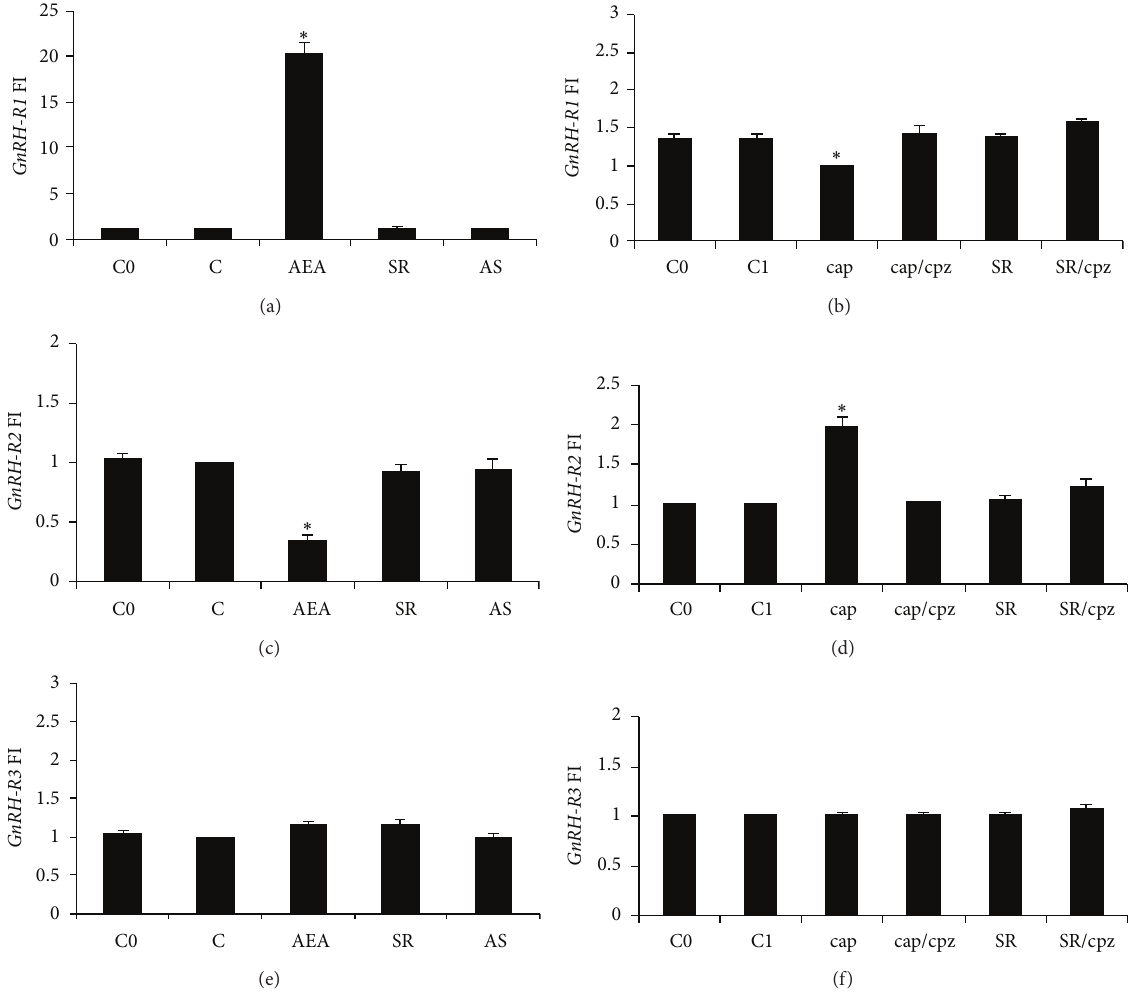
Figure 4: Effects of AEA treatment on GnRH-R1 (a), GnRH-R2 (c), and GnRH-R3 (e) expressions in frog testis collected from June animals ( 𝑁 = 5 /group) after 1h of incubation. Incubations have been carried out with AEA 10 −9 M, SR 10 −8 M, or both. C0: untreated testis of June; C: control group, testis treated with Krebs-Ringer buffer. Effects of cap treatment on GnRH-R1 (b), GnRH-R2 (d), and GnRH-R3 (f) expressions in frog testis of June after 1h of incubation. Incubations have been carried out with cap 10 −6 M, cpz 10 −5 M, SR 10 −8 M, or combinations of cap/cpz and SR/cpz. C0: untreated testis of June; C1: control group, testis treated with Krebs-Ringer buffer. The data in graph are the results of RT-PCR analysis; they are reported as fold increase (FI) calculated comparing the expression of GnRH-Rs to the housekeeping fp1 and are representative of three separate experiments at least ( 𝑁 = 6 ). Asterisks indicate statistically significant